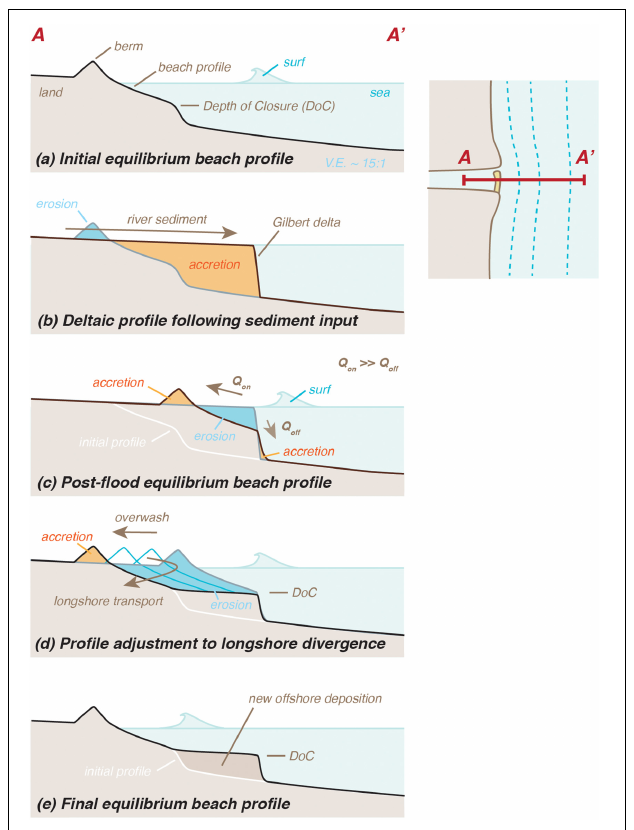
FIGURE 10 | (a–e) Generalized morphodynamic model for river mouths with Gilbert-like delta during and after sediment input from the river based on observations from the Elwha River of Washington. The onshore and offshore fluxes ( Q on and Q off , respectively) of sediment are shown with arrows, and the vertical exacerbation (V.E.) is approximately 15.